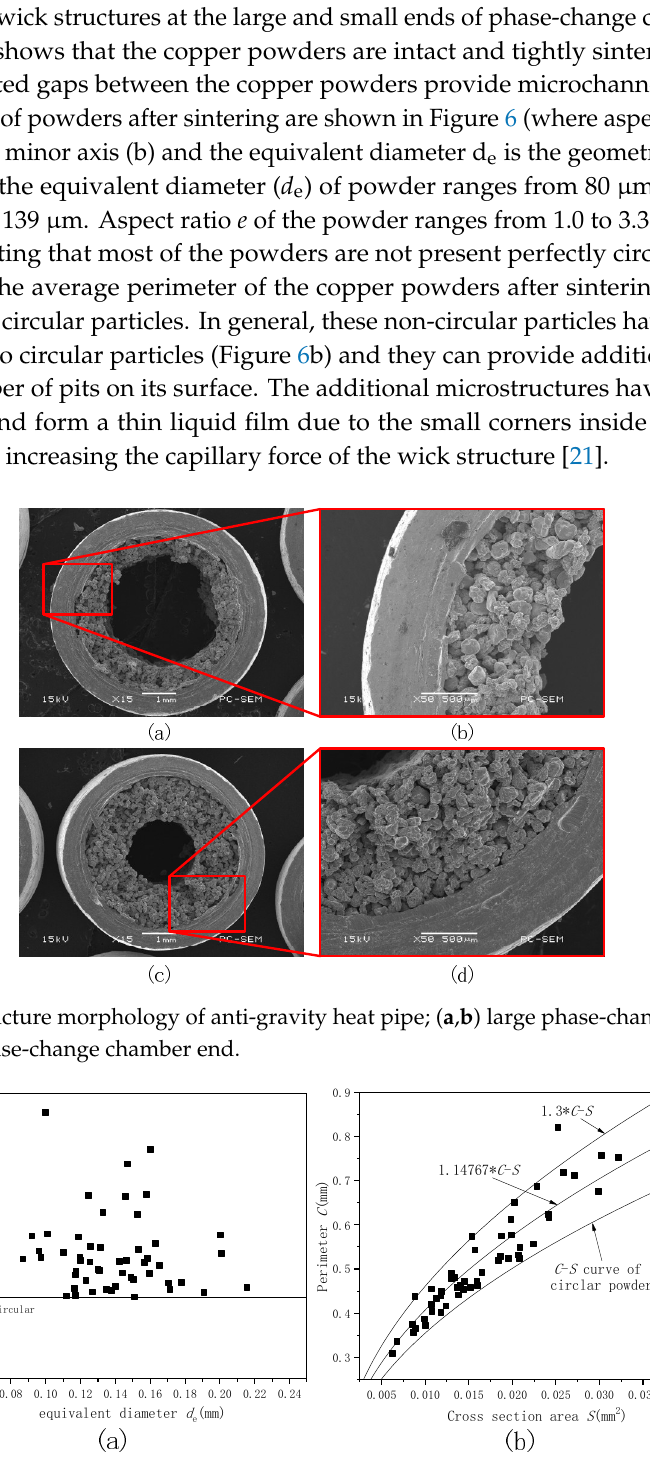
Figure 6. Relation between ( a ) aspect ratio and equivalent diameter, and ( b ) perimeter and cross section area of copper powders within the sintering wick structures.